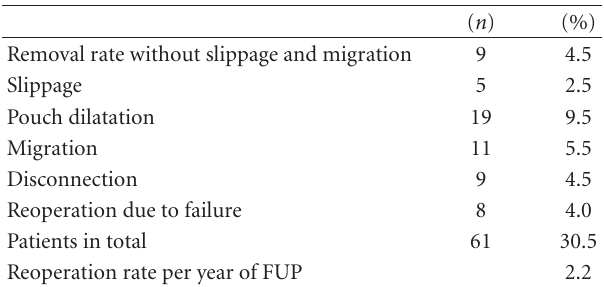
Table 4: Overall reoperation